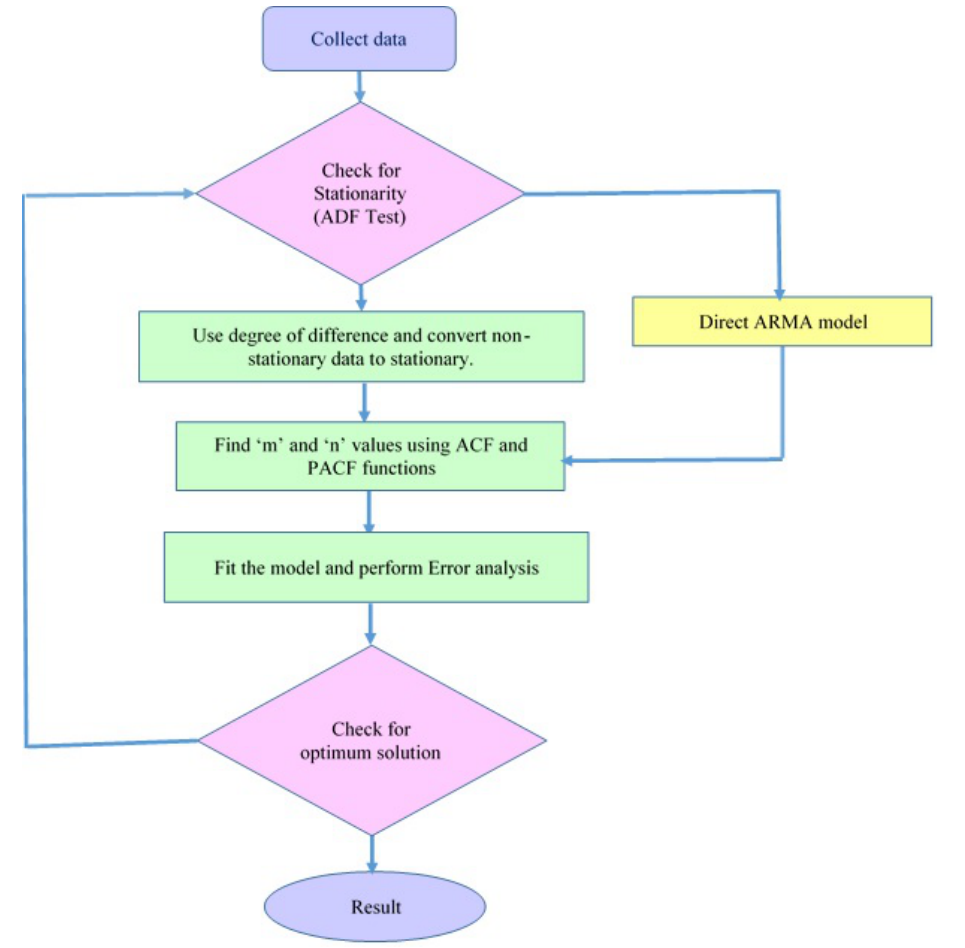
Figure 6. Flow chart for ARMA and ARIMA